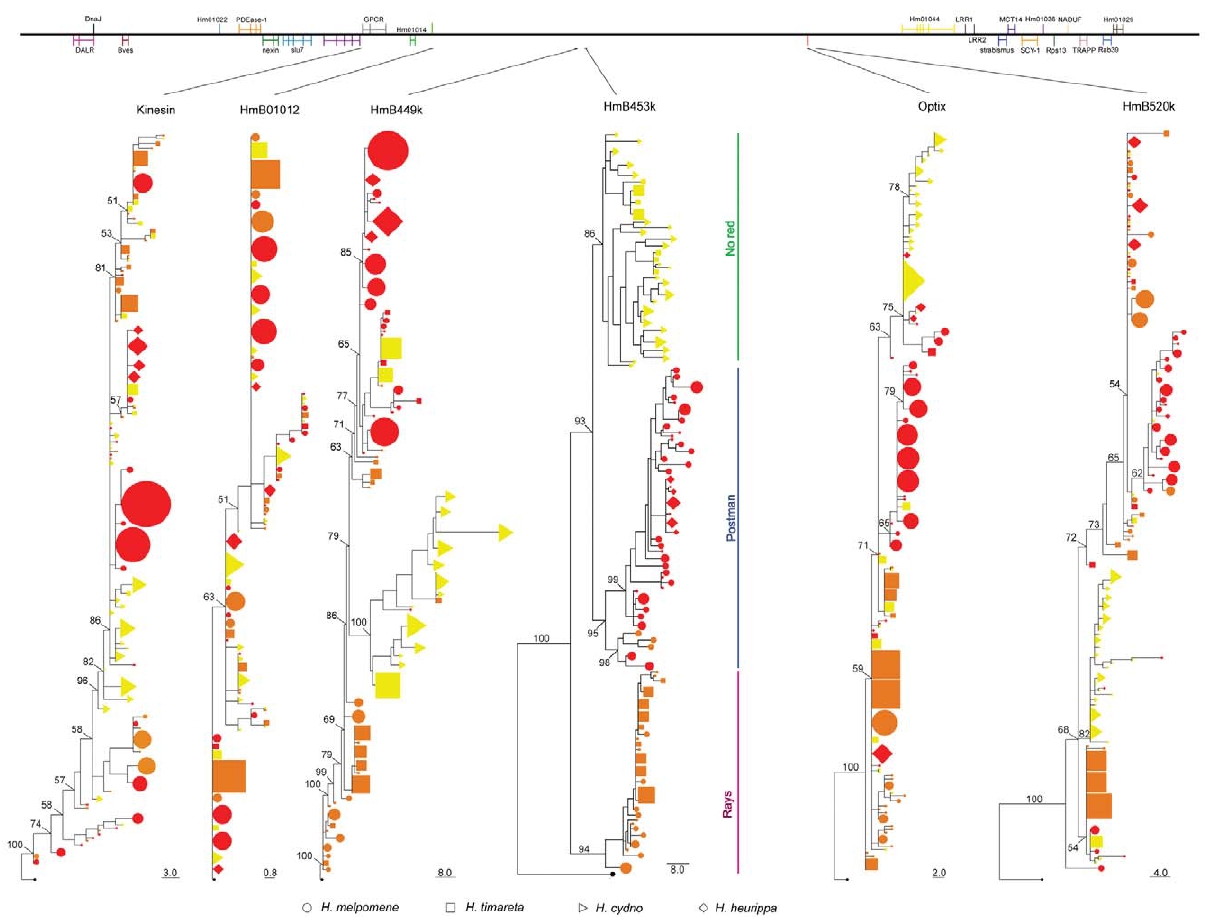
Figure 3. Phylogenetic clustering of the red colour linked markers. Top panel represents the order and gene content in the HmB red locus, with vertical lines representing exons. Lines drawn from top panel indicate the location of the marker in the HmB locus. All of the topologies were inferred by Neighbour-Joining clustering. Numbers above branches are the values for bootstrap support. Species and colour codes are as specified in Figure 1, with (a) H. melpomene (circles) and (b) H. cydno (triangles), H. timareta (squares) and H. heurippa (diamonds). H. numata (black) was used as outgroup. Size of shapes represents haplotype frequency. Taxa with a rayed phenotype are coloured orange, red-banded phenotypes are red and those taxa lacking a dorsal red wing phenotype are